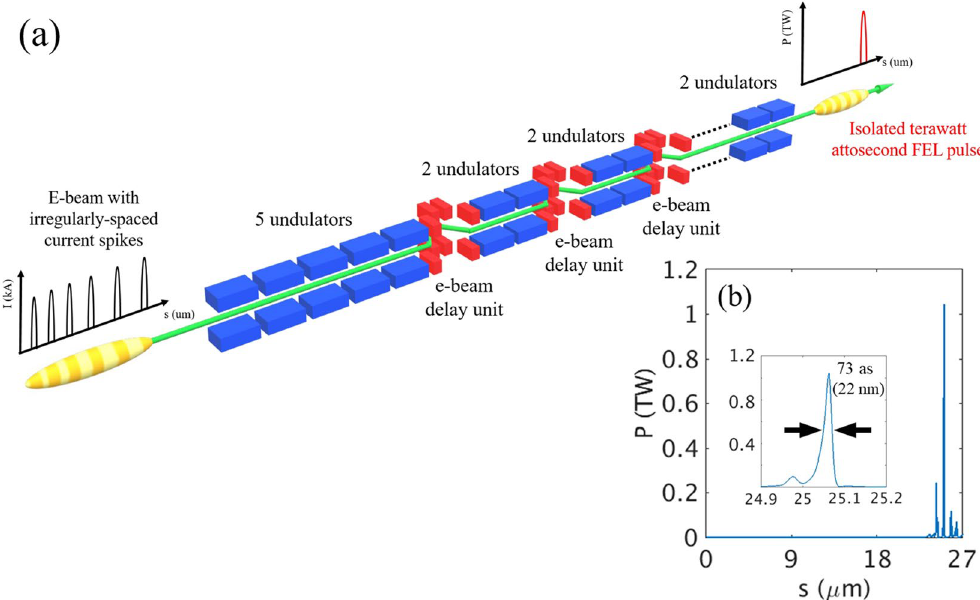
Figure 7. ( a ) Undulator section layout for multi current spike method. Red blocks: electron beam delay units between undulators. ( b ) Temporal profile of XFEL pulse with 23 undulators; inset: expanded view of main radiation pulse.